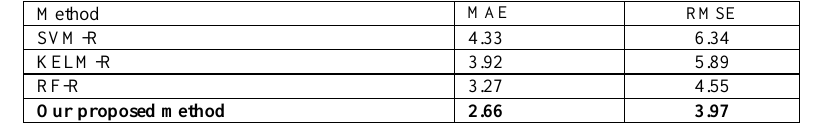
Table 1. Comparison of prediction results with traditional machine learning regression methods.